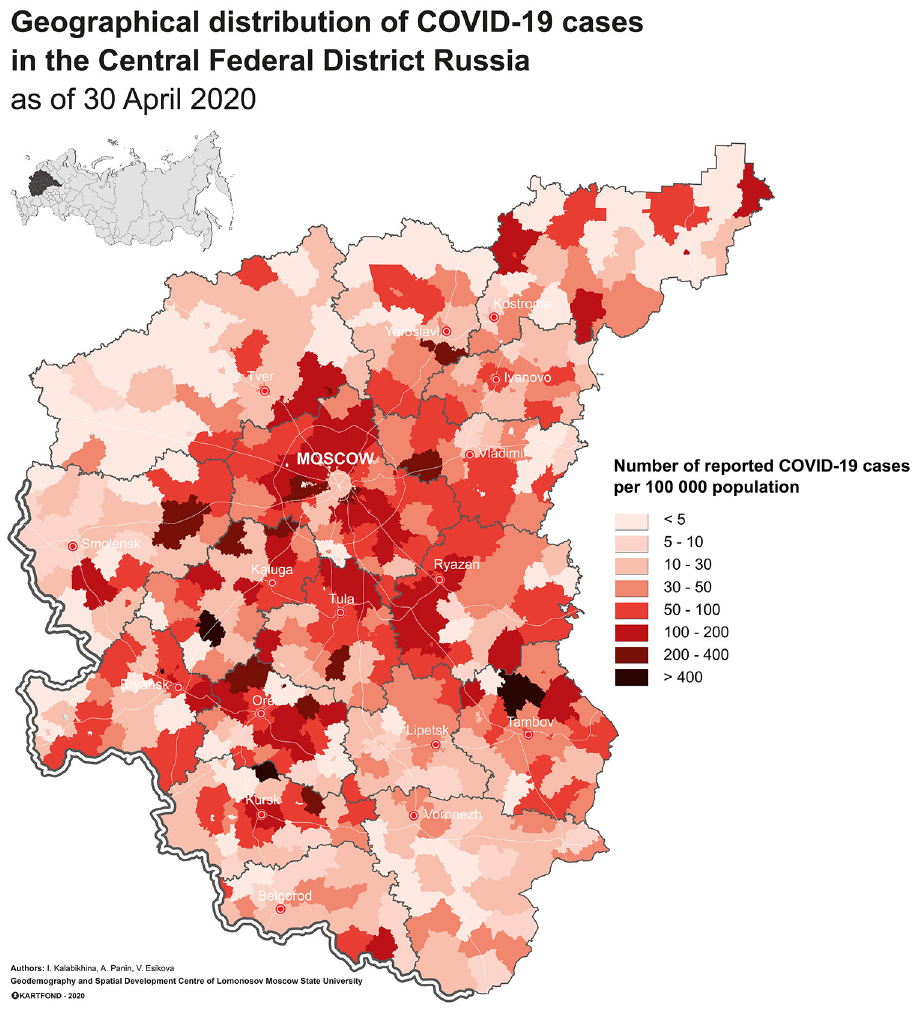
Figure 15. Geographical distribution of COVID­19 cases in the municipalities of the Central Federal District of Russia, number of reported COVID­19 cases per 100 thousand population, 30.04.2020, ac­ cording to Rospotrebnadzor (2020). Source: Compiled by the researchers of the Geodemography and Spatial Development Centre of the Population Department of the Economics Faculty of Lomonosov Moscow State University together with the “Kartfond” research